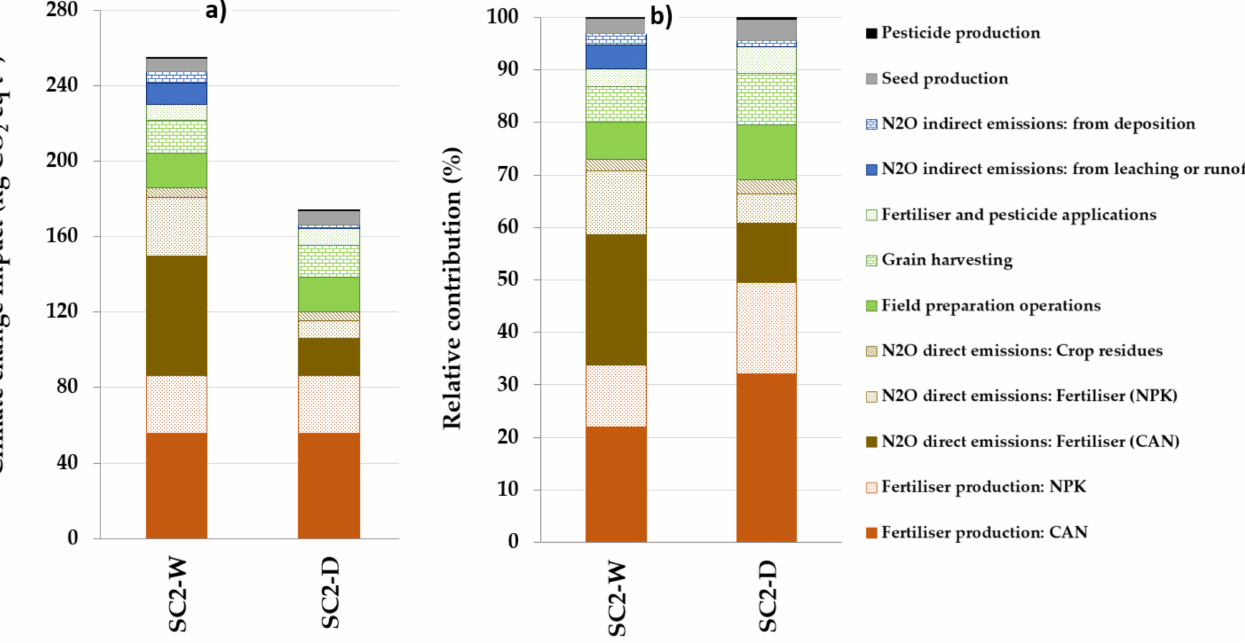
Figure 6. Climate change impact for SC2 scenario (mass-based allocation + 2019 Refinement) simulated under wet (W) and dry (D) climate: ( a ) kg CO 2 eq t − 1 and ( b ) percentage of relative contribution of the main emissions